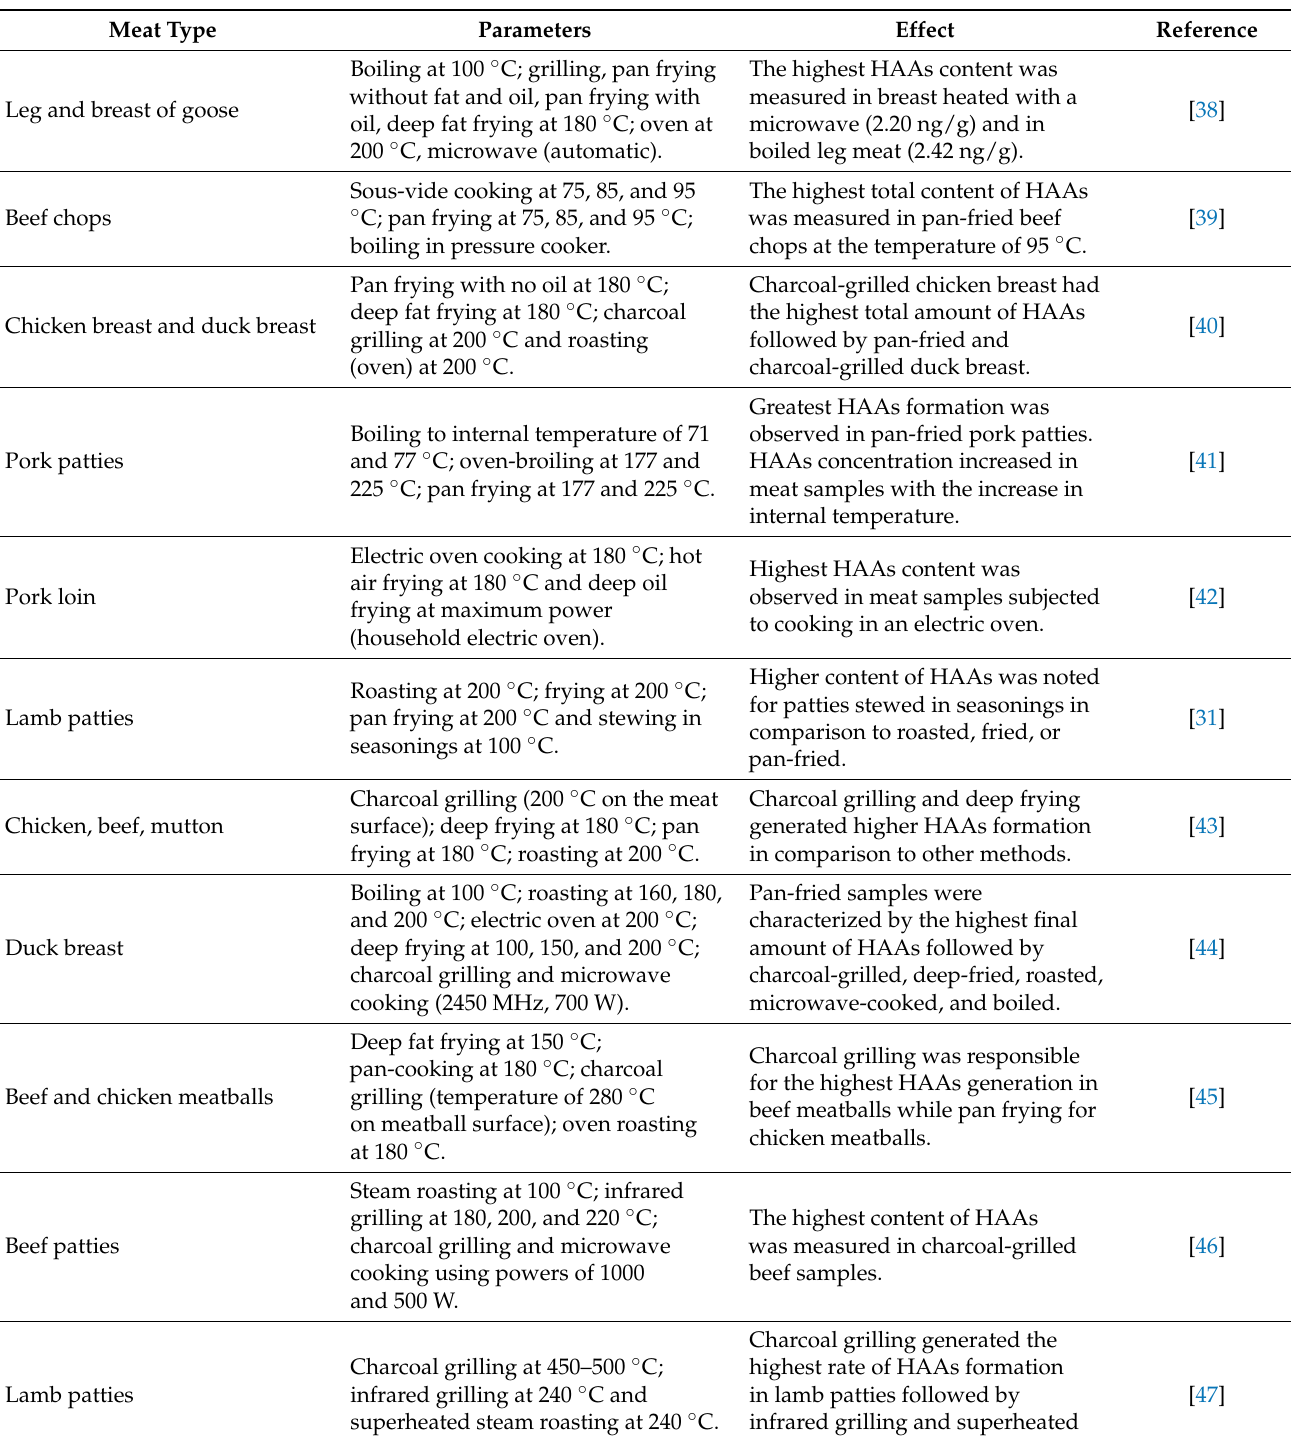
Table 1. The combined effect of cooking method and temperature on the final content of HAAs in meat